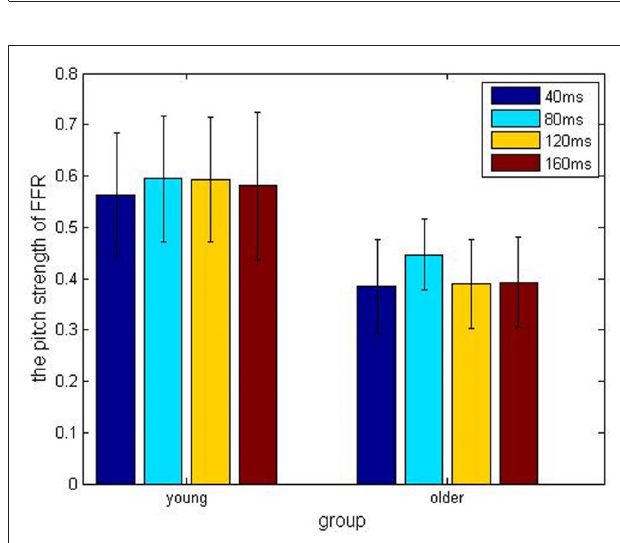
FIGURE 5 | The pitch strength result obtained from the young (yellow) and the elderly (green) groups, under different